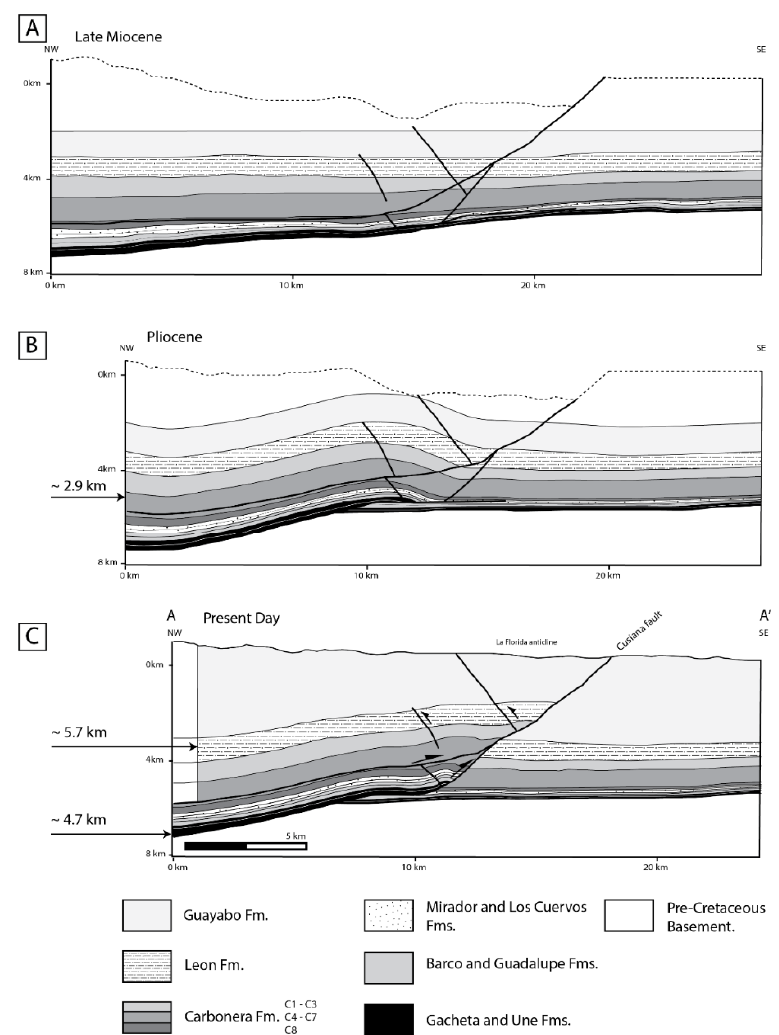
Figure 3. Retrodeformed model of the La Florida anticline (Albesher et al., 2019) during ( A ) late Miocene, ( B ) Pliocene, and ( C ) present time, respectively. See the location in Figure 1.